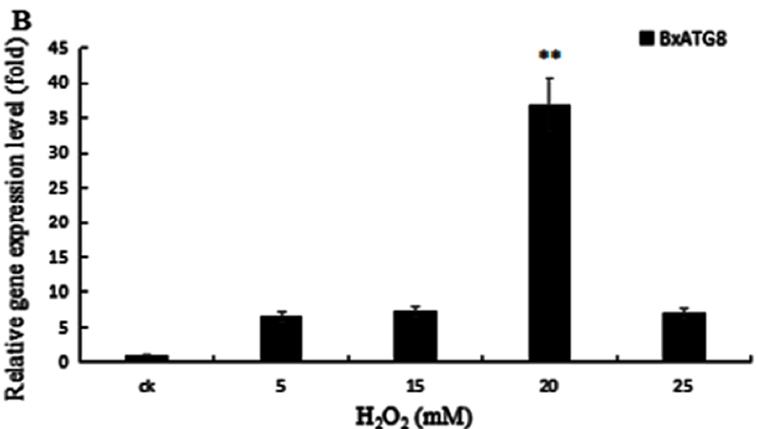
Figure 5. Quantitative reverse transcription PCR (qRT-PCR) analysis of: BxATG1 ( A ); and BxATG8 ( B ), in PWN after treated with oxidative stress. The expression level of the control was set as 100%. Data represent mean ± SD from three independent experiments. Bars show standard deviations of the mean. Asterisks on top of the bars indicate statistically significant differences (** p < 0.01, Student’s t -test).